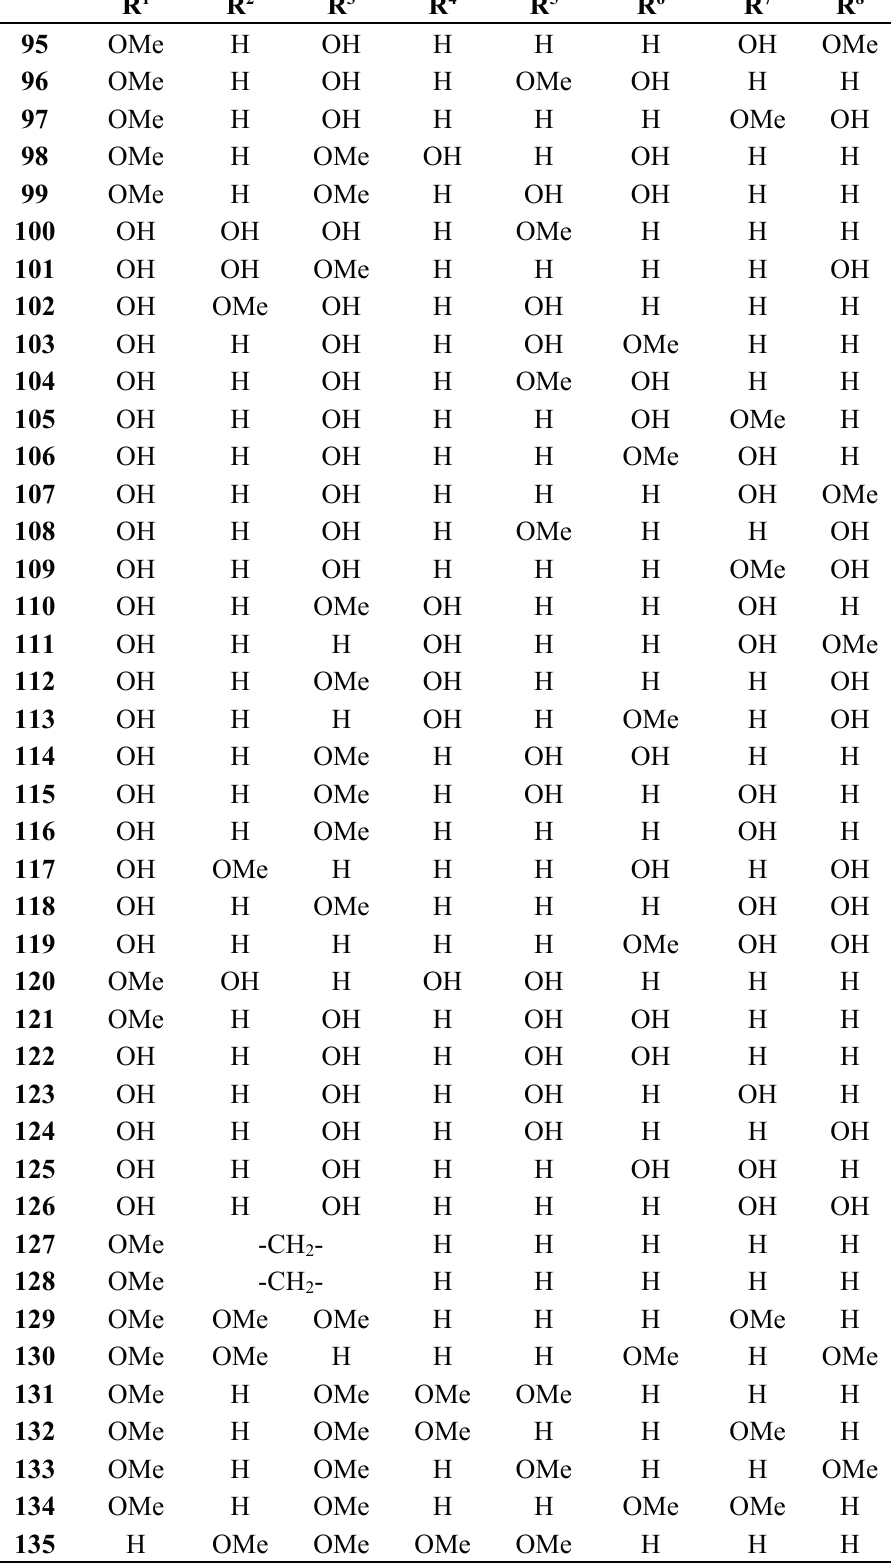
Figure 4. Chemical structures of tested tetraoxygenated